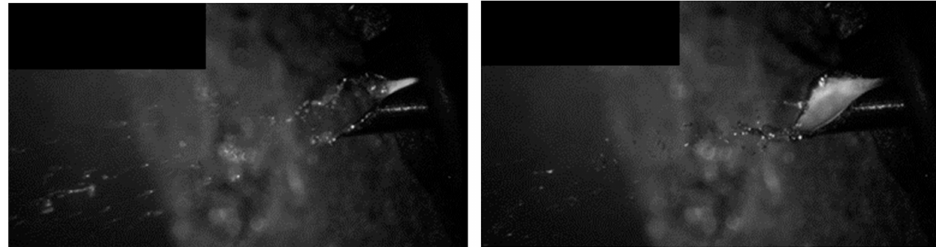
Figure 5. Particle formation during wire arc spraying with pulsed direct current at time ( left ): t = 11.4 ms, ( right ): t = 12.2